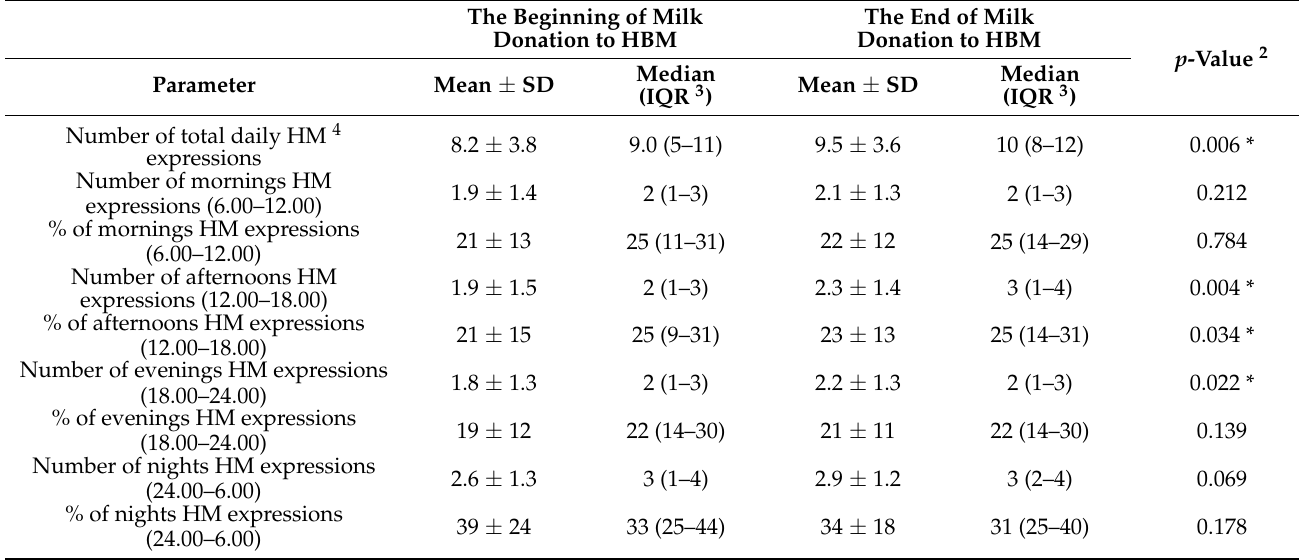
Table 2. The number and percentage 1 of HM expressions at different time